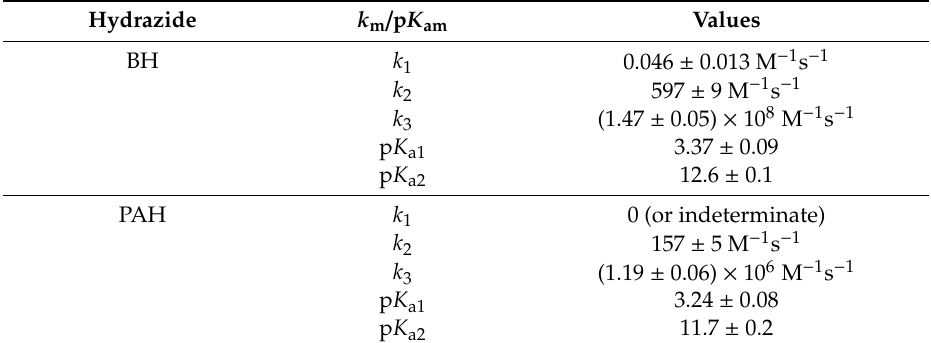
Table 2. Rate constants for the rate-determining steps and protolysis constants in Figure 7 for the reactions of BH and PAH determined at 25.0 °C and ionic strength μ = 1.0 M.